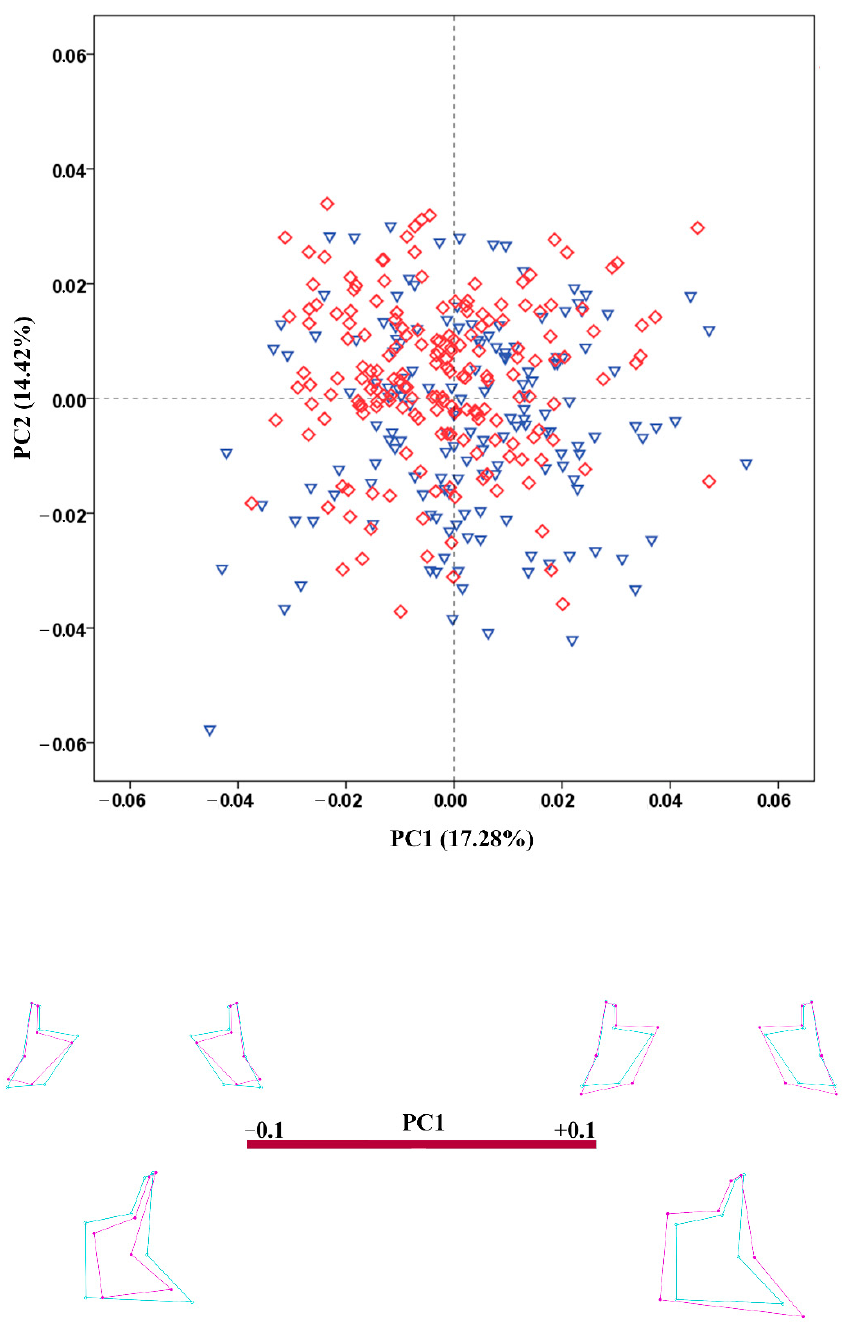
Figure 7. PCA scatterplot for the configuration of the zygomatic region. The wireframes illustrate the shape variation along the axis of PC1. Male crania—blue triangles; female crania—red rhombs; extreme shape configurations—purple wireframes; mean shape configuration—light blue wireframe.